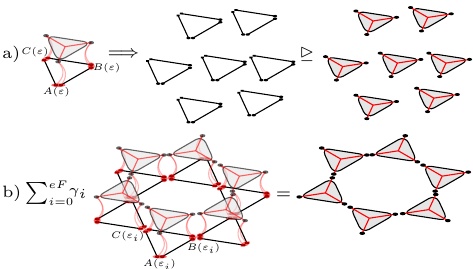
Figure 4: Graphical representation of Theorem 14: a) A local degeneration ( A ( (cid:34) ) , B ( (cid:34) ) , C ( (cid:34) ) ) depending polynomially on (cid:34) from one plaquette state (pairwise entangled states between three parties) to another ( λ state), gives rise to a global degeneration between a collection of F plaquette states. b) Evaluating the degenera- tion at eF + 1 points (cid:34) , we can express the full entanglement structure built from the i second plaquette state (here λ states) as a superposition of eF + 1 states that arise as restrictions from the first entanglement structure (here pairwise entangled states between three parties). The parameter e is a scaling factor depending on the poly- nomial degree of the local degeneration, the prefactor γ is obtained by evaluating i the i th Lagrange polynomial (cid:96) at i